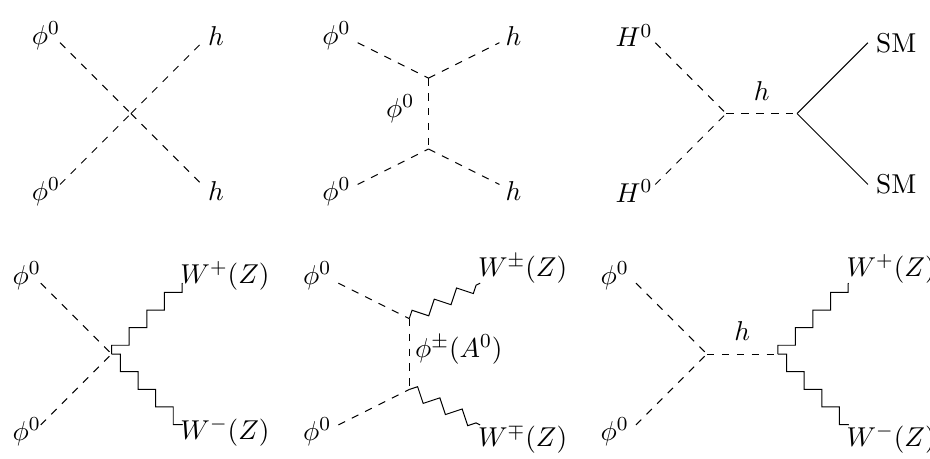
Figure 27. Feynman diagrams for DM annihilation to SM particles for the Scalar DM ( φ 0 ).